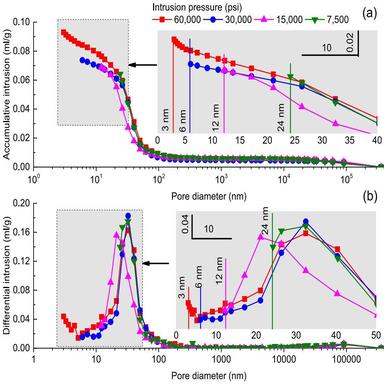
Intrusion PSDs of the HCP samples with different maximum applied pressures: (a) APSD and (b) DPSD curves of the P-04 samples.